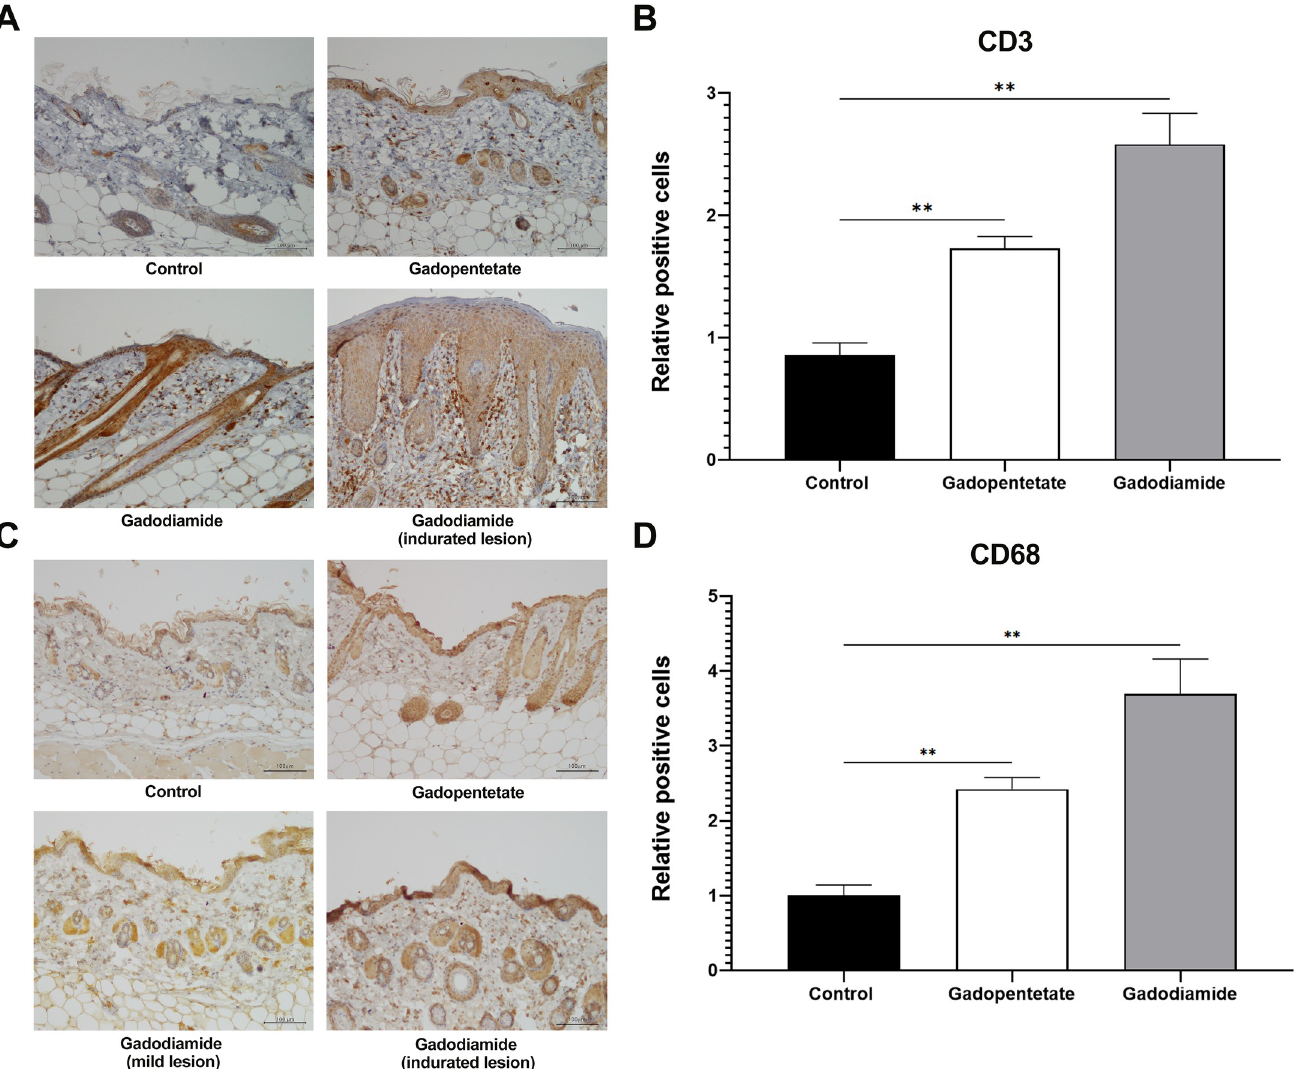
Fig 3. Effect of GBCAs injection on the CD3 and CD68 expression on the skin. Representative photomicrographs of CD3 + T cells (A) and CD68 + macrophage immunostaining (C). Quantification number of infiltrated CD3 + T cells (B) and CD68 + macrophages (D) in the dermis, determined by counting cells in six random microscopic fields. The expression of CD3 + cells was significantly higher in the gadodiamide group compared to the control group, in mice with mild lesions and mice with severe lesions. Similar results were also observed in the CD68 + expressed cells. Scale bar = 100 μ m. The expression of positive cells in control mice was assigned values of 1. All data represent the mean score ± SEM. �� p <